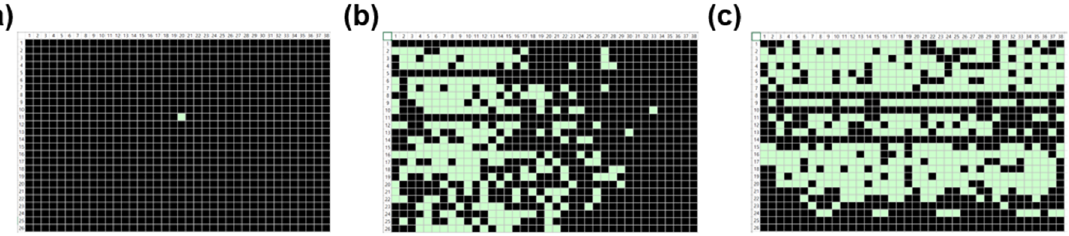
Figure 7. Statistical maps generated from PICR2R-TFT measurements of the 26 × 38 SWCNT-TFT arrays with a channel length of 60 µm printed at various speeds: ( a ) 30 mm/s, ( b ) 60 mm/s, and ( c ) 90 mm/s (light box: “pass”, dark box: “fail”).